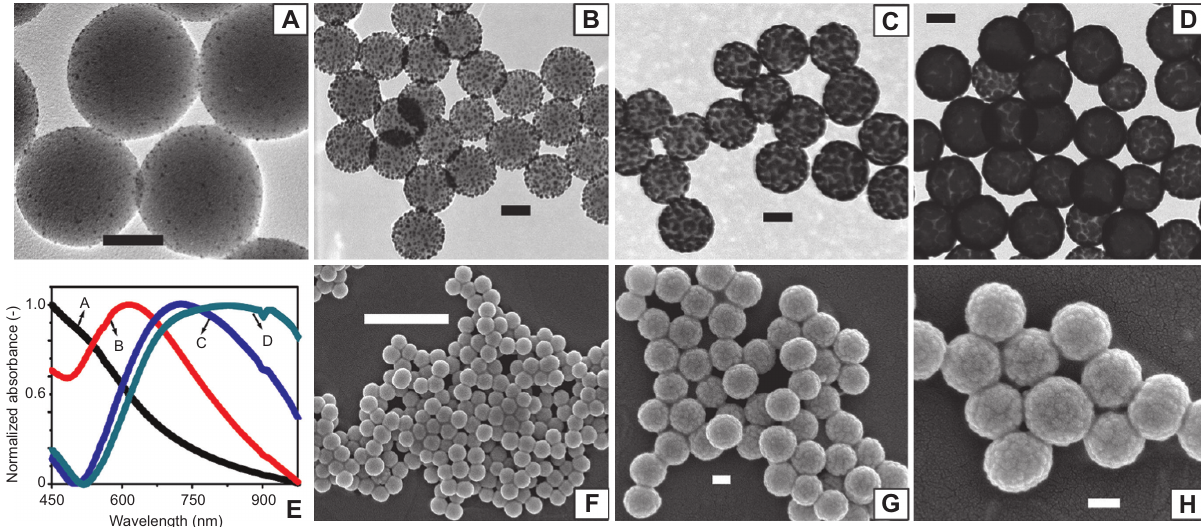
core particles. Figure 6 TEM images of gold-seeded SiO 2 The density of the surface coverage depends on the ionic gold concentration and the volume fraction of gold-seeded silica particles (A) within the growth solution. The corresponding values are as follows: (B) 0.29 mm, 1.2 × 10 -2 %, (C) 0.39 mm and 3.8 × 10 -3 %, and (D) 0.4 mm and 3.4 × 10 -3 %. The UV-Vis extinction spectra in (E) display a red shift of the spectral position of the plasmon resonance wavelength with an increasing surface coverage in connection with a half-width widening due to an anisotropic growth of gold islands with different size. (F, G) Corresponding SEM images of the TEM recordings above. All scale bars correspond to 100 nm except for (F) (1 μ m). Reprinted with permis- sion [133]. Copyright © 2010, American Chemical